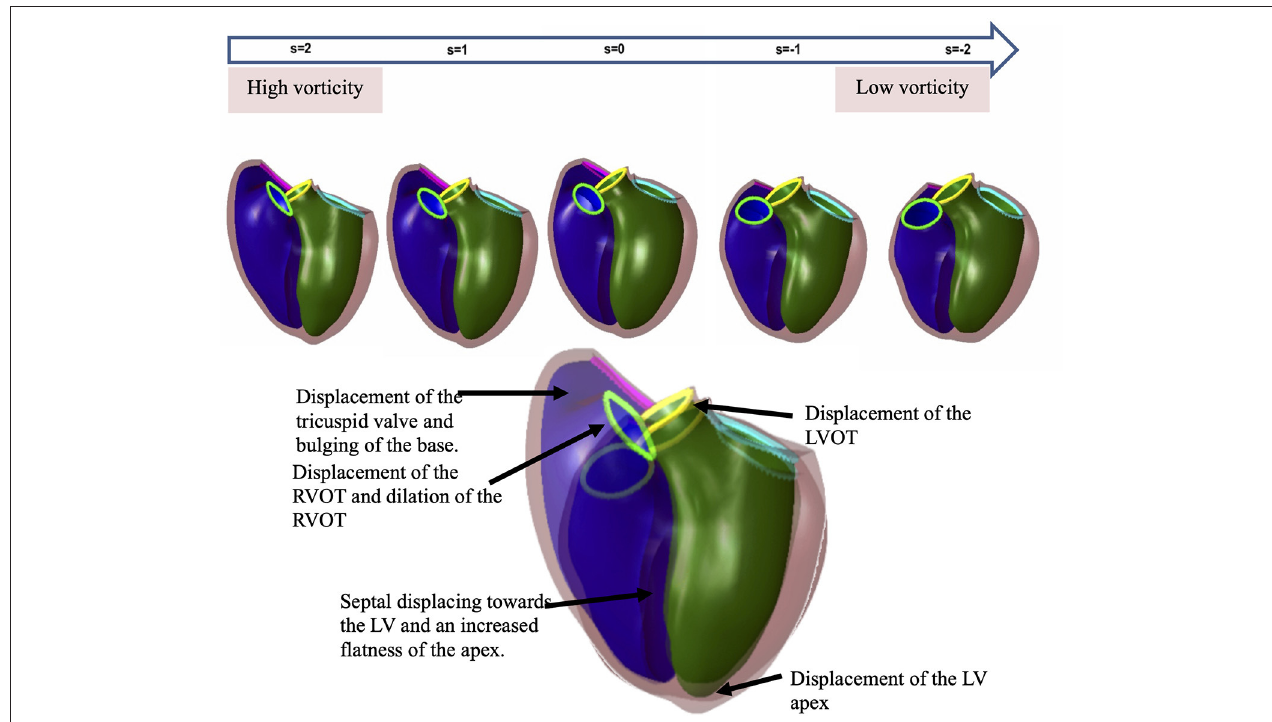
FIGURE 5 | The effect of vorticity on the shape of the RV by a regression model. The spectrum of shapes is demonstrated in the line of shapes above to show the difference between a normal biventricular model (far right) and a model affected by high vorticity (far left). The larger overlapping shapes emphasize the differences. The RV enlargement affects the orientation of both the pulmonary and tricuspid valves. There is an architectural shift from the normal configuration to an enlarged bulging base. There is an evident effect on the LV as well showing the change in wall shape and position of the aortic and mitral valves due to the shift in the RV outflow tract